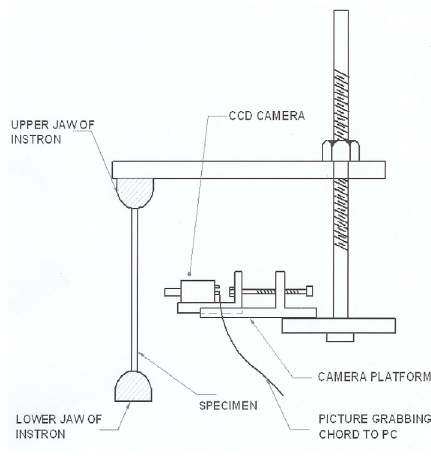
Figure 4: UTM (INSTRON) Machine. Figure 5: CCD camera